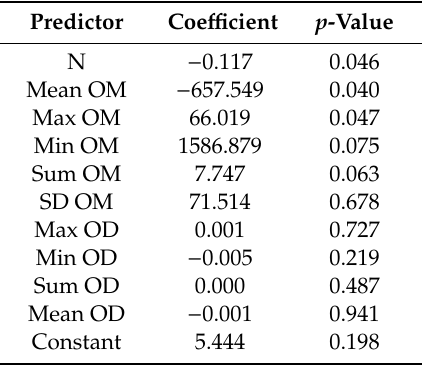
Table 5. Model based on tra ffi c conditions (low vs. high tra ffi